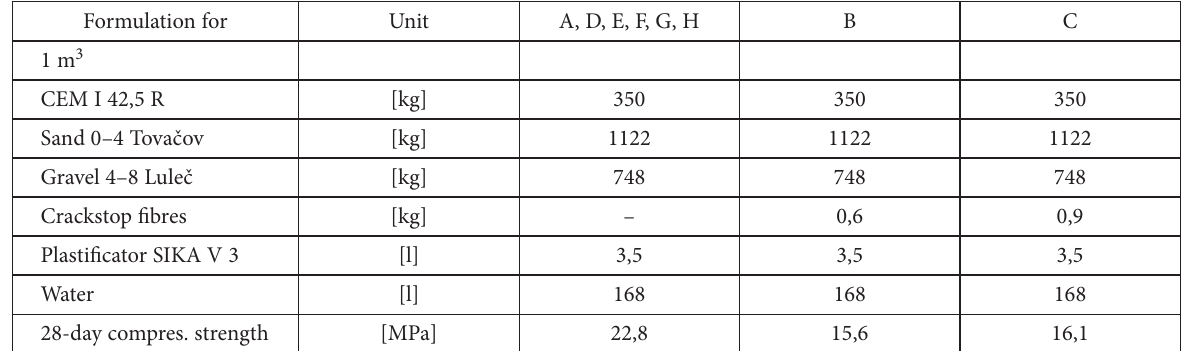
Table 1 . Concrete mixture composition + compression strength Formulation for